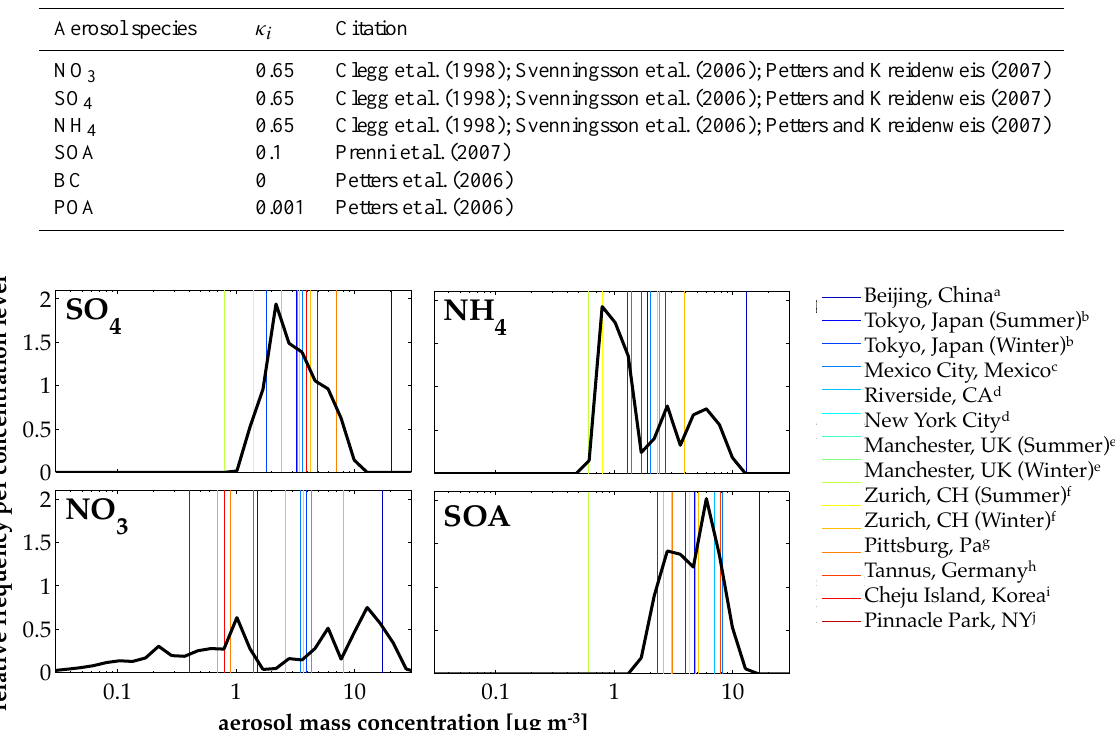
aerosol mass concentration [ " g m -3 ] ! Figure 3. Probability density function of aerosol mass species in simulations (black line in each graph) show that model cases represent variation in atmospheric conditions from ambient observations (vertical colored lines). Probability density functions include all output time steps in the full ensemble of sensitivity simulations. References for observations corresponding to each line: (a) Sun et al. (2010), (b) Takegawa et al. (2005, 2006), (c) Aiken et al. (2009), (d) DeCarlo et al. (2008); Docherty et al. (2008); Cubison et al. (2006), (e) Drewnick et al. (2004a, b), (f) Weimer et al. (2006), (g) Allan et al. (2003a, b), (h) Lanz et al. (2007), (i) Zhang et al. (2004, 2005a, b, c, 2007), (j)